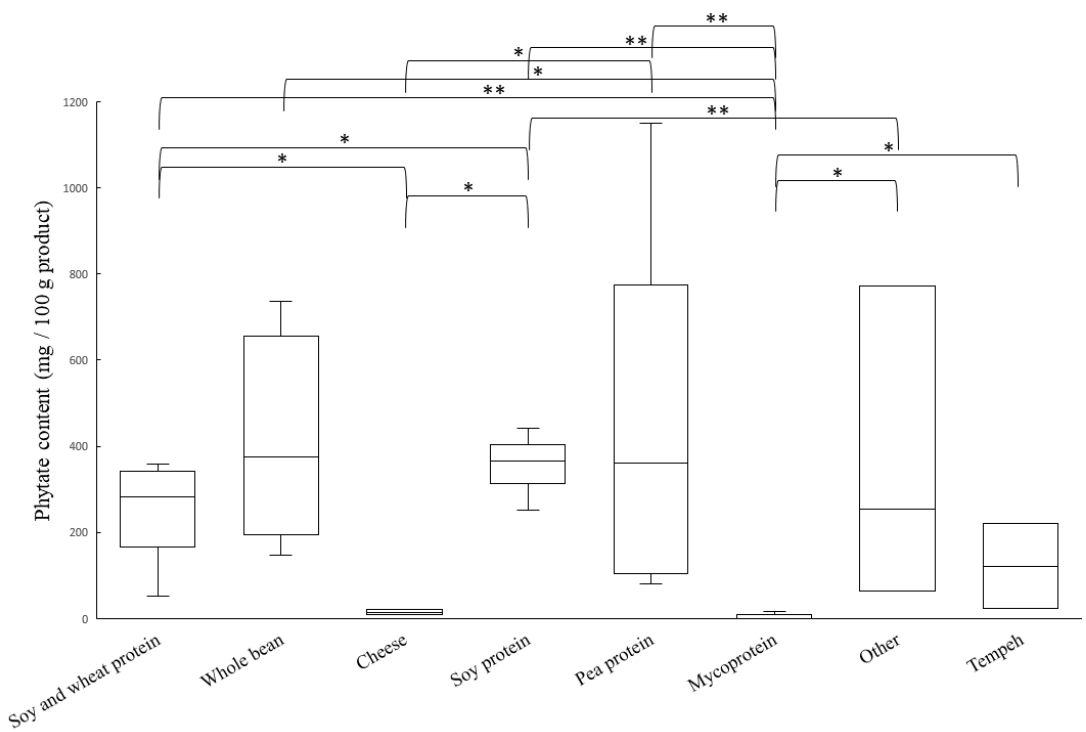
Figure 3. Boxplot of phytate content. Line inside the box shows the median value, top of each box is the 75th percentile, and bottom of each box is 25th percentile. Whiskers are maximum and minimum values. A p -value < 0.05 is illustrated with * and a p -value < 0.01 with **.